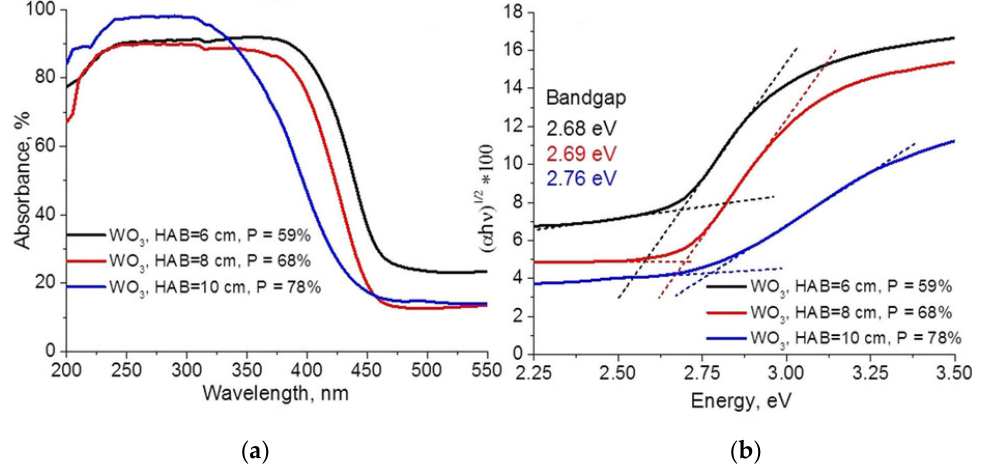
Figure 10. ( a ) UV/Vis spectra obtained for tungsten-oxide NPs collected at different heights above burner (HABs). ( b ) Tauc plots obtained for the same samples [17]. Reproduced with permission from Chen, H., et al., ChemPlusChem; published by Chemistry Europe, 2018.